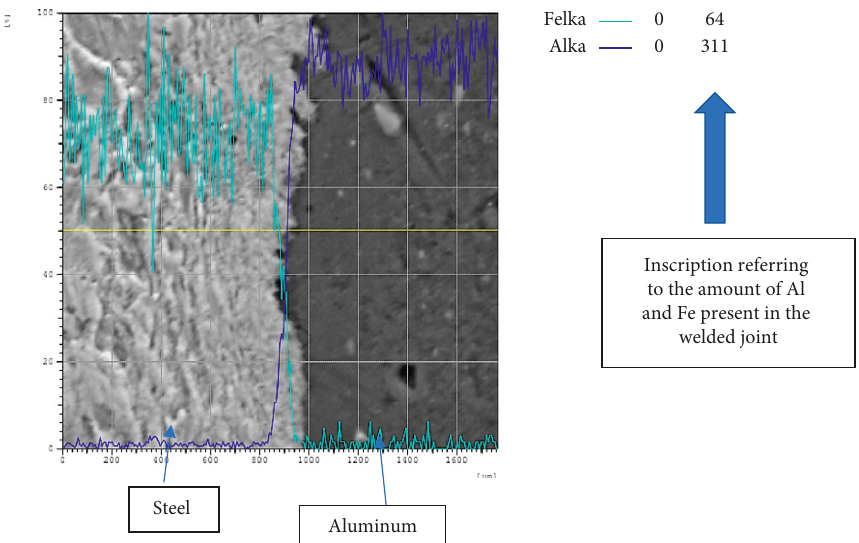
Figure 6: Semiquantitative analysis performed by EDS at the junction of aluminum and